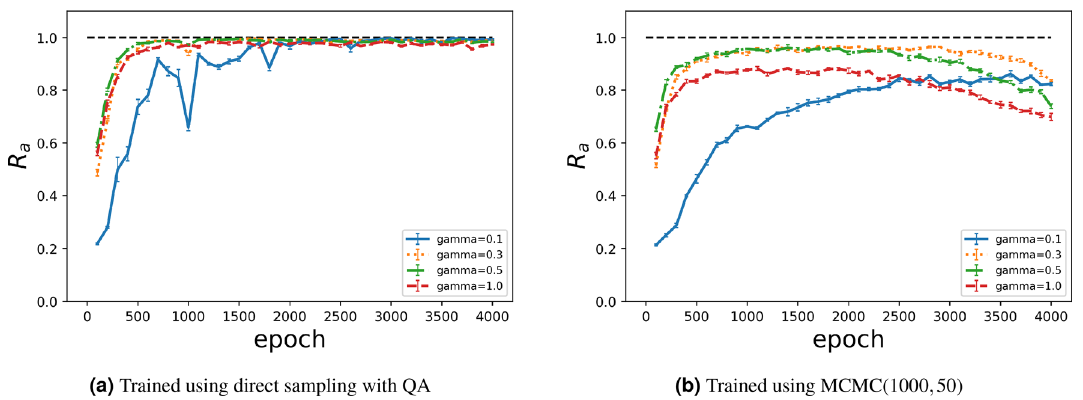
Figure 9. R a over 4000 epochs for images generated using quantum Monte Carlo